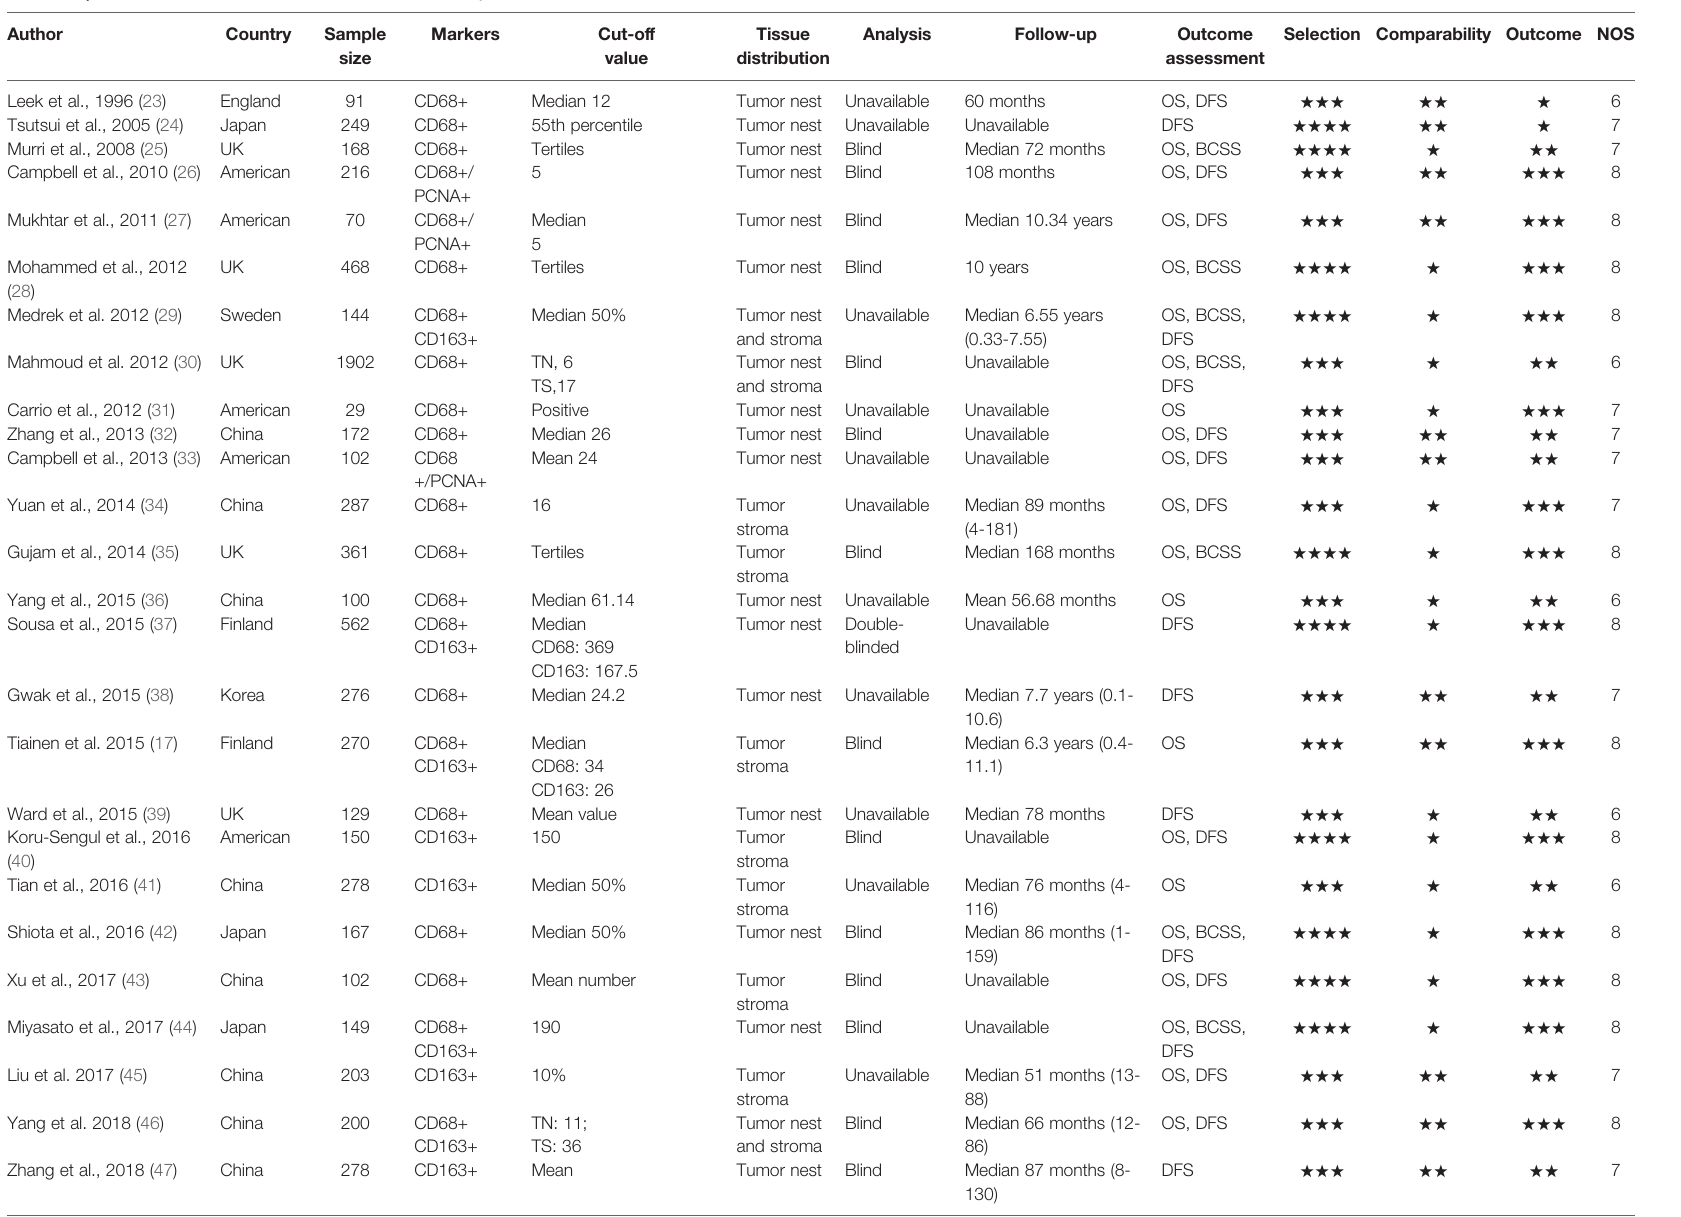
TABLE 1 | Characteristics of studies included in the